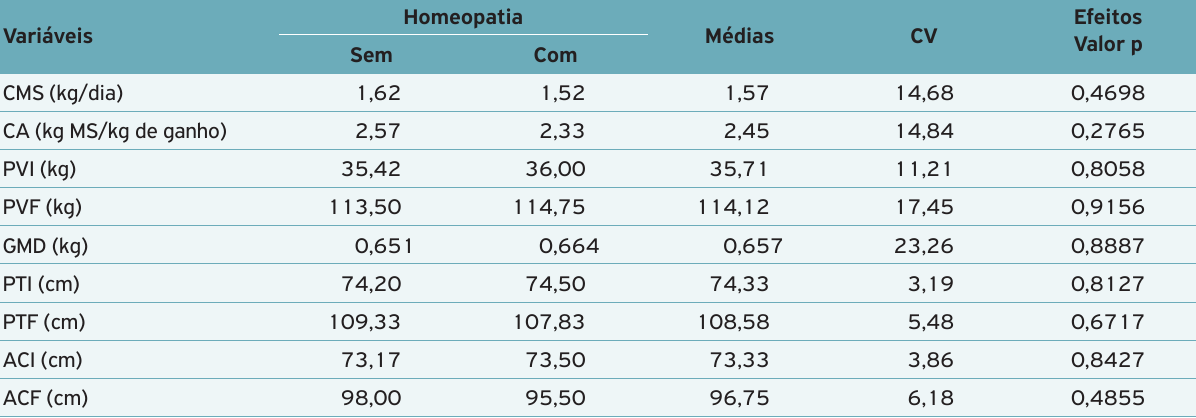
Tabela 2. Consumo de matéria seca, conversão alimentar, ganho médio diário por animal, peso vivo inicial e final, perímetro torácico inicial e final, altura da cernelha inicial e final e as respectivas médias, coeficiente de variação e valores de probabilidade em bezerras na fase de cria (0 a 120 dias de idade) (Colina,